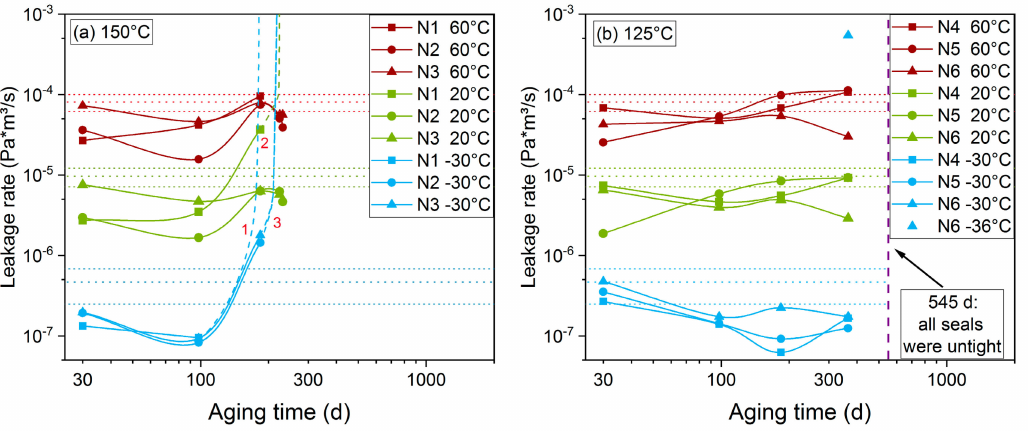
Figure 6. Static leakage rate measured at 60 ◦ C, 20 ◦ C, and − 30 ◦ C on HNBR O-rings aged at ( a ) 150 ◦ C and ( b ) 125 ◦ C. The dotted horizontal lines represent the average value of three unaged O-rings for each test temperature and the respective standard deviation